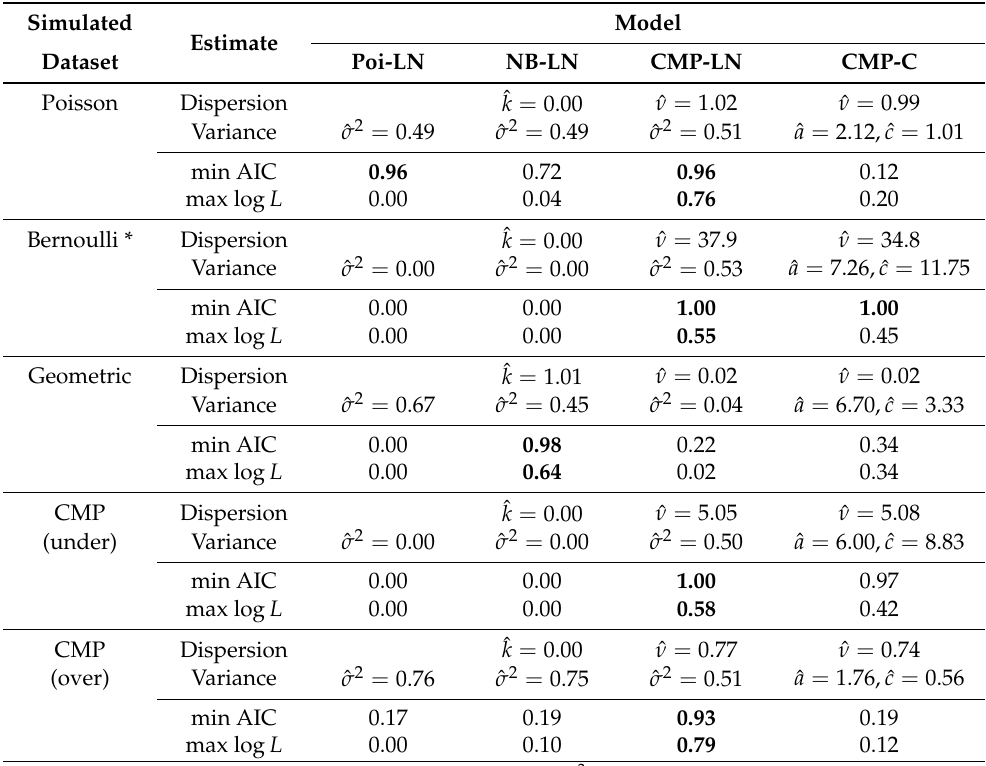
Table 1. Average of dispersion and variance estimates, and model fit measures for simulated data in Scenario I. Model fit measures: min AIC is the proportion of 50 replications where AIC ≤ min(AIC) + 2, and max log L is the proportion of 50 replications where log L is largest. Bold values indicate the model with the largest proportion of min AIC or max log L